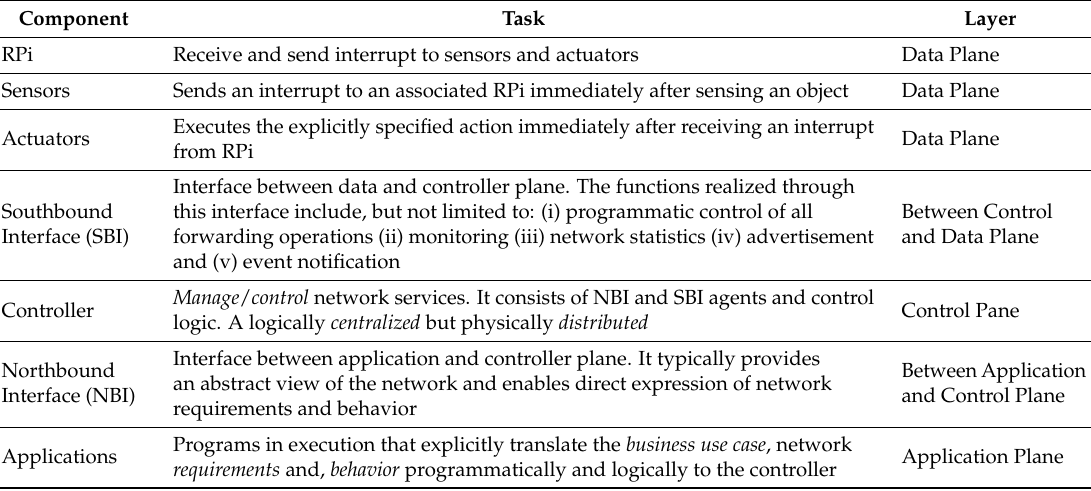
Table 3. SDIAN (Software Defined Industrial Automation Network) architectural